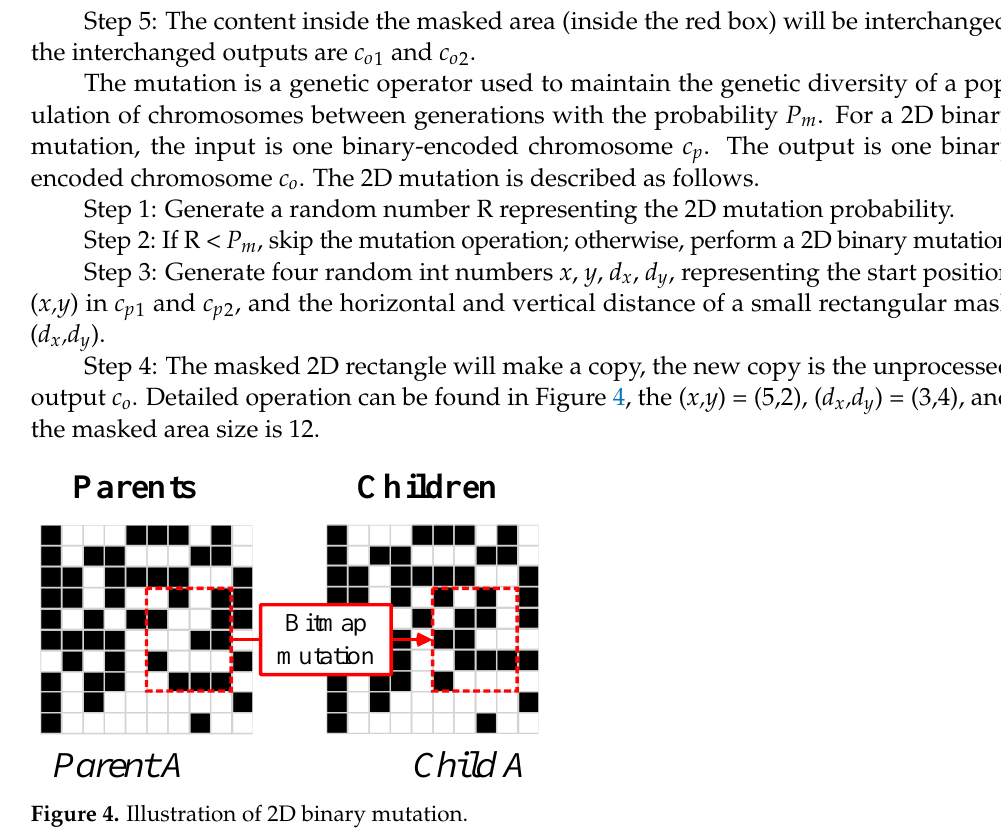
Figure 3. Illustration of 2D binary crossover.